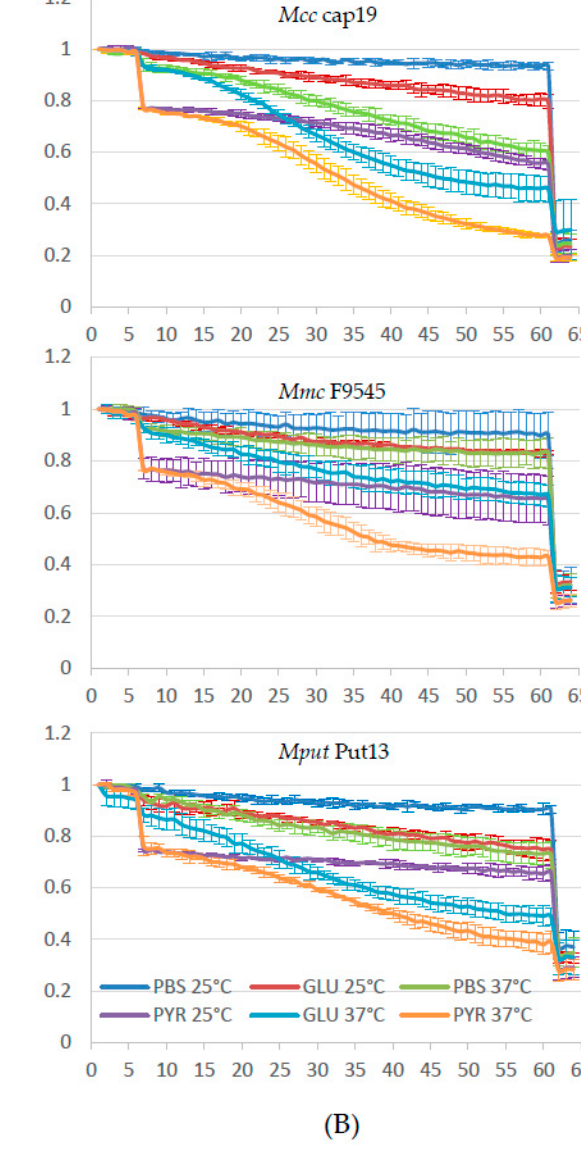
Figure 2. Determination of ethidium bromide efflux by fluorometry in cell suspensions of M. agalactiae ( A ) and M. mycoides cluster or related ( Mcc , M. capricolum subsp. capricolum ; Mmc , M. mycoides subsp. capri ; Mput , M. putrefaciens ) ( B ) strains. Experiments were conducted at 25 °C or 37 °C, with or without the addition of an energy source (pyruvate, PYR or glucose, GLU) at t = 5 min. The complete release of EtBr was obtained by addition of SDS (1 %) at t = 60 min. x -axis, time in minutes; y -axis, mean relative fluorescence (of three repeated measures, with standard deviations).